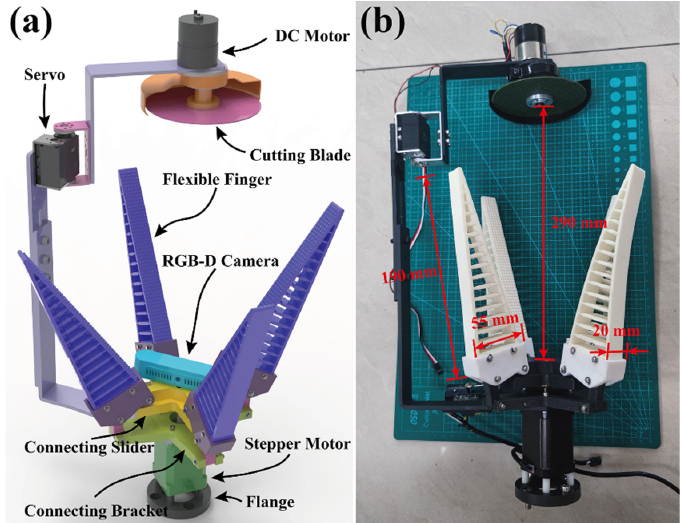
Figure 4. Structure diagram of the developed end-effector for autonomous harvesting of watermelon: ( a ) the three-dimensional structure schematic; ( b ) the end-effector prototype.